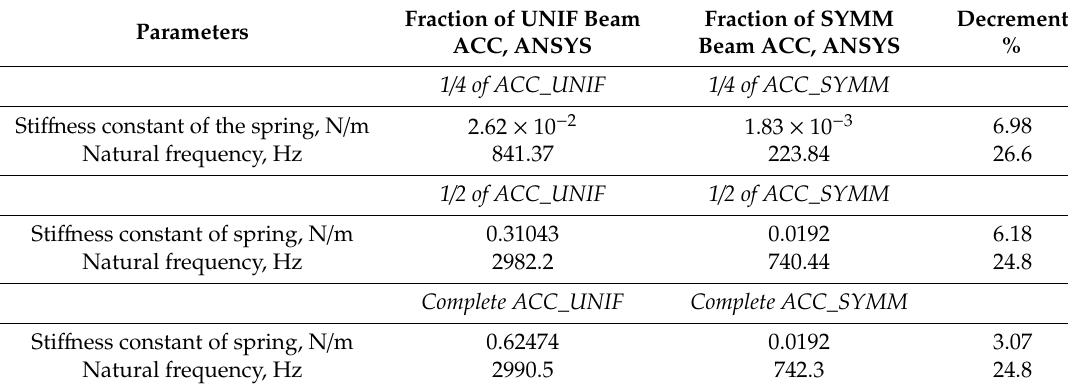
Table 7. Sti ff ness constant of uniform and symmetrical beams and operation frequency of the 1 / 4 , 1 / 2 and complete accelerometers.